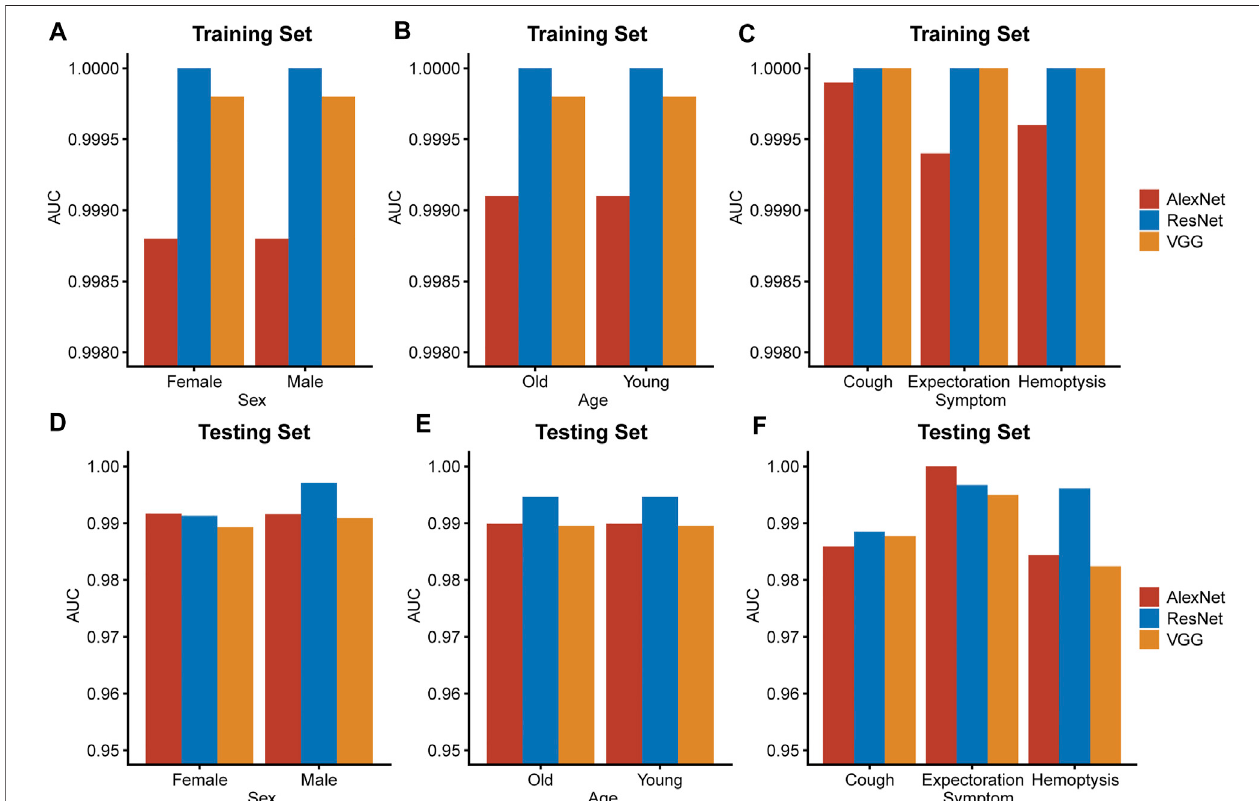
FIGURE4| Strati fi cationanalysis.Subgroupingbyimportantclinicalcharacteristics,includingsex (A,D) ,age (B,E) andrespiratorysymptoms (C,F) ,AUCvaluesof the three models were calculated and compared in both sets. Young: under 65 years old. Old: 65 years old or over 65 years old.